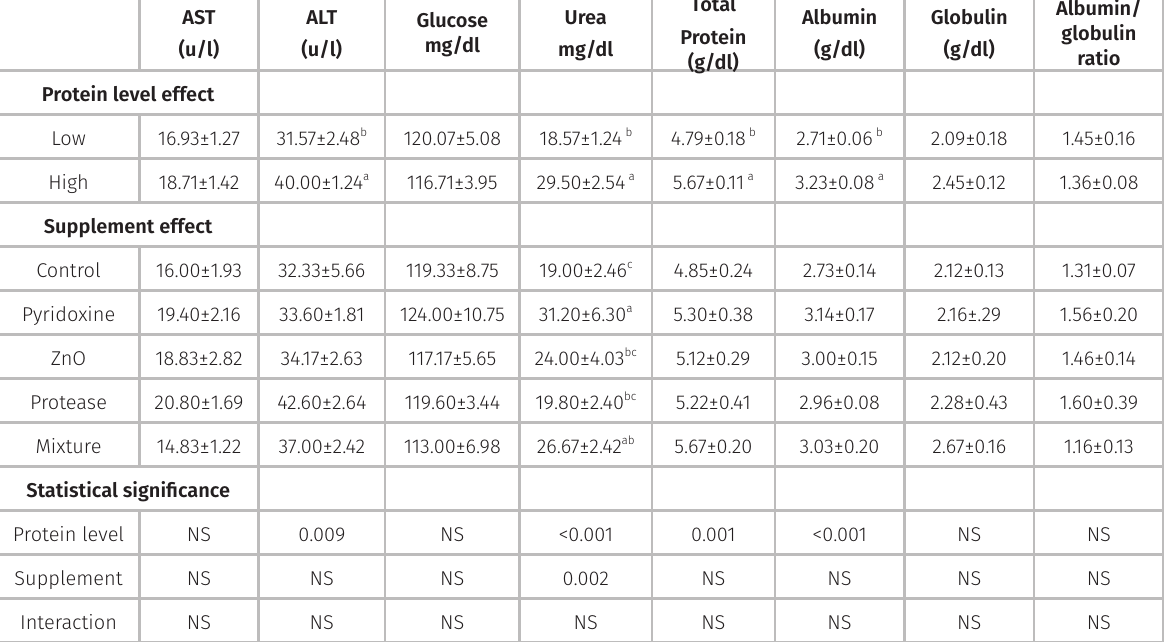
Table V. Blood parameters (Mean± SE) of New Zealand White rabbits as affected by protein level and tested feed